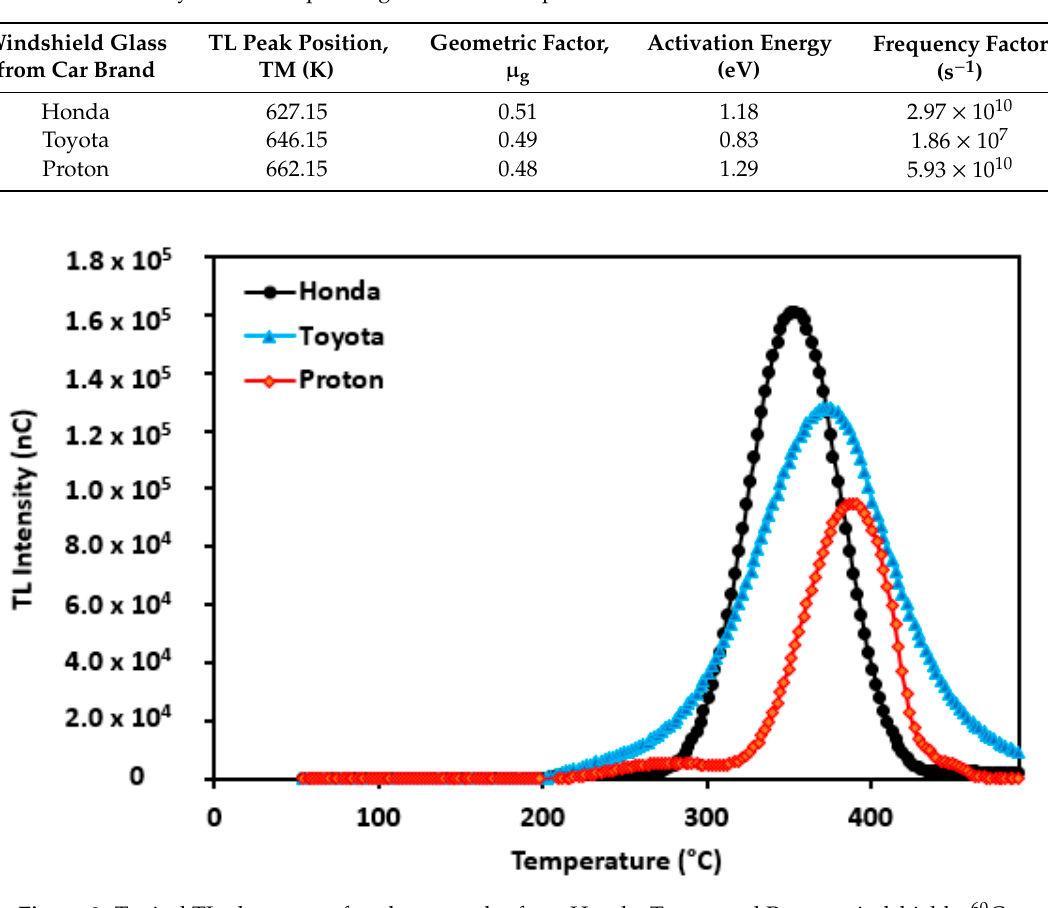
Figure 2. Typical TL glow curve for glass samples from Honda, Toyota and Proton windshields, 60 Co irradiated to a fixed dose of 10 Gy.